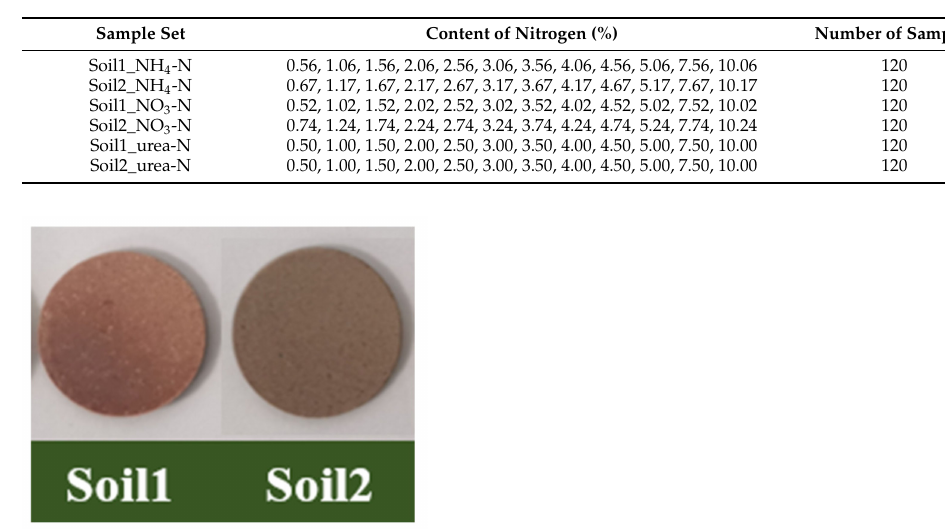
Table 6. Soil nitrogen content of 6 sample sets.